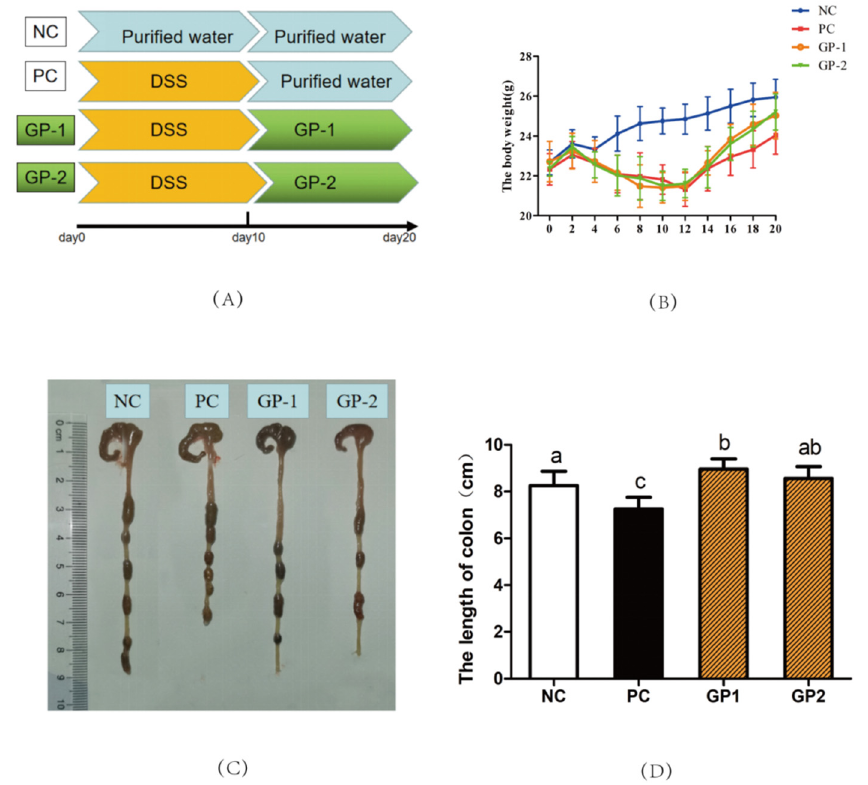
Figure 3. GP attenuated DSS-induced colitis in mice. Experimental design for the mice with DSS-induced colitis. The mice were assigned to four groups ( A ): NC, normal control; PC, positive control (1.5% DSS was supplied in water); GP-1 and GP-2, oral with 100 and 300 mg/kg/day respectively. ( B ) the change of body weight of mice during the trial. ( C ) Photographs of the colon. ( D ) Length of colon. All values represent the means ± SD ( n = 8), and different letters represent significantly different of p < 0.05 according to the one-way ANOVA (Tukey’s Multiple Comparison Test) analysis. Without the inflammatory stimulation, the colon showed intact colonic mucosa, crypts, stroma, and submucosa, and few inflammatory cells infiltrated in submucosa and ulceration in NC (Figure 4A). After DSS treatment, the mice showed intense inflammatory lesions, including the hyperplasia of crypts, the increased macroscopic spaces between crypts, severe epithelial cells damage, submucosal edema, and inflammatory cellular infiltration in the submucosa, which were similar to the previous report on the DSS-induced colitis model [11]. However, the treatments of GP ameliorated the inflammatory symptoms in the colon, including relative intact surface epithelium, lower infiltration of inflammatory cells, mild submucosal edema, and crypt glands close to NC. According to the histopathological score (Figure 4B), the PC groups showed much higher scores than NC ( p < 0.05), and the pretreatment of GP decreased histopathological score as being expected ( p < 0.05). In the study of Wan et al. [11], the body weight of mice was decreased after 8 days of DSS treatment. Depending on the DAI score, the body weight and the colon length were all alleviated in the supplement of dicaffeoylquinic acids revealing the anti-inflam- matory effect of dicaffeoylquinic acids in IBD mice. The intake of γ -Glutamyl cysteine peptides ( γ -EC, 150 mg/kg) was also checked to suppress the IBD symptoms of reducing weight loss, stool blood, and diarrhea levels in colitis mice. Where the γ -EC participated in the regulation of calcium-sensitive receptors along with the regulation on c-Jun N-ter- minal kinase (JNK) and nuclear factor kappa-B (NF- κ B) pathways, thus playing a role in ameliorating the inflammatory symptoms of IBD [6]. Inconsistent with previous studies, the typical symptoms of weight loss, mucosal inflammation as well as hematochezia